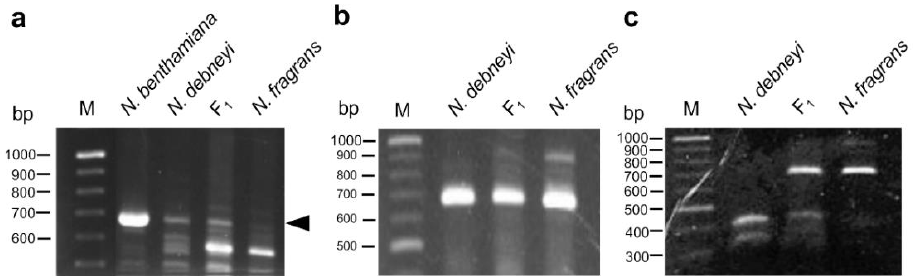
Figure 4. DNA markers developed based on the scaffold Niben101Scf06736 in the v1.0.1 genome of N. benthamiana . ( a ) STS marker Nb7 (arrowhead). ( b , c ) CAPS marker Nb14-CAPS. Undigested PCR products ( b ) and PCR products treated with Hha I ( c ) are shown. Lane M, size marker (GeneRuler DNA ladder mix).